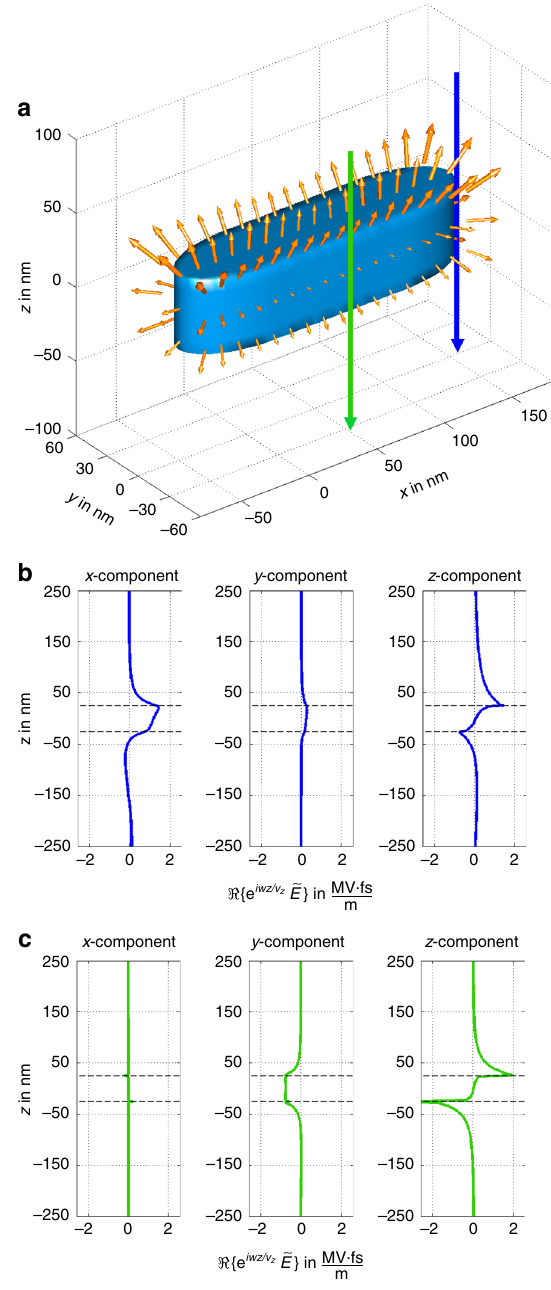
Fig. 4 Simulations of induced fi elds. Simulated spectrally resolved electric fi eld distribution in a 3D and b , c 1D along lines indicated in a . The fi elds exhibit a strong con fi nement to the rod surface as well as the symmetry (antisymmetry) of the x , y ( z ) components with respect to the central plane ( z = 0) of the rod. Consequently, representative values of the lateral fi elds may be obtained from the 2D projections after dividing with the rod thickness. Please note that the integral of the z -component, as in b , c , is always positive due to the slower decay of the fi eld above the the spatial resolution of the reconstructed response. Secondly, a combination of IMT with multiple tilt-axis tomography (i.e., tensor fi eld tomography) would allow the 3D reconstruction of all components of the dielectric response without relying on addi- tional assumptions. This relates to and includes the so-called optical density of states (i.e., the spatial diagonal of the dyadic Green ’ s function G ( r , r ′ = r , ω ) mentioned in Theory), which has